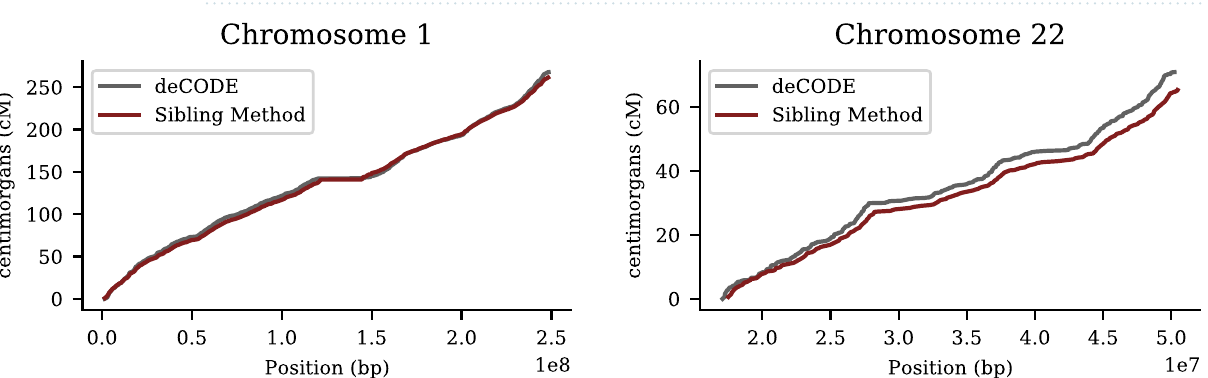
Figure 11. Genetic Health Index for GP/IVF families (centered). Far left histogram describes GP embryos in aggregate. Middle histogram describes GP IVF embryos after recentering with respect to parental midpoint. Individual families are displayed on the right with mother represented by a circle and father by a square. Families on right are displayed after recentering at midparent Index.